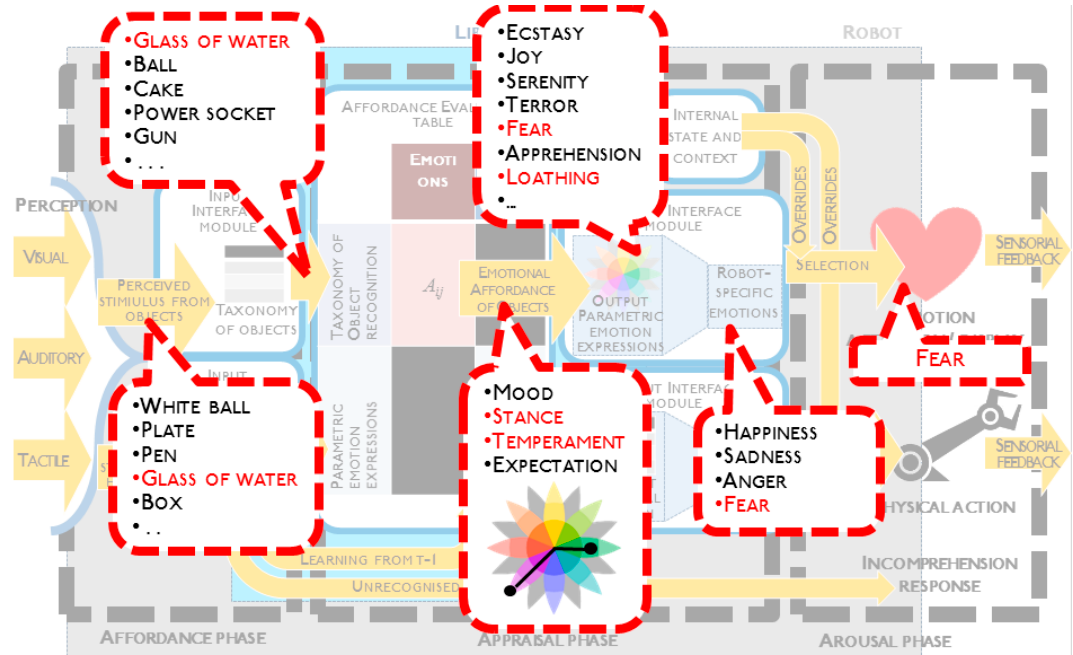
Figure 6. Summary of the object-to-emotion affordance process.